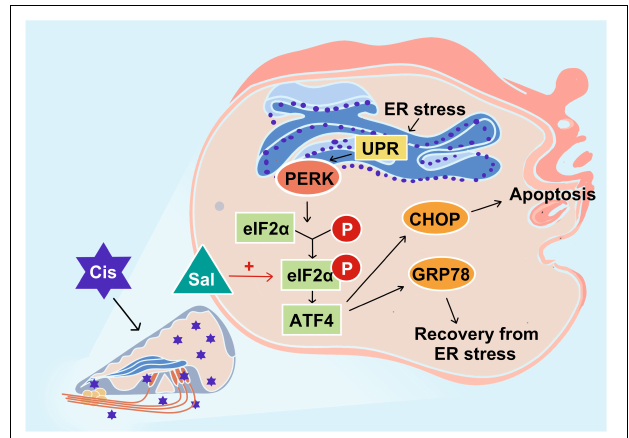
FIGURE 8 | Schematic diagram showing the specific regulatory role of endoplasmic reticulum stress in cisplatin-induced ototoxicity and the main signalling branch exerting a pro-apoptotic effect. PERK and its related PERK/eIF2 α /CHOP signalling branch are speculated to play a major role in cisplatin-induced ototoxicity. Sal increases the anti-apoptotic effect of GRP78 by inhibiting the dephosphorylation of eIF2 α